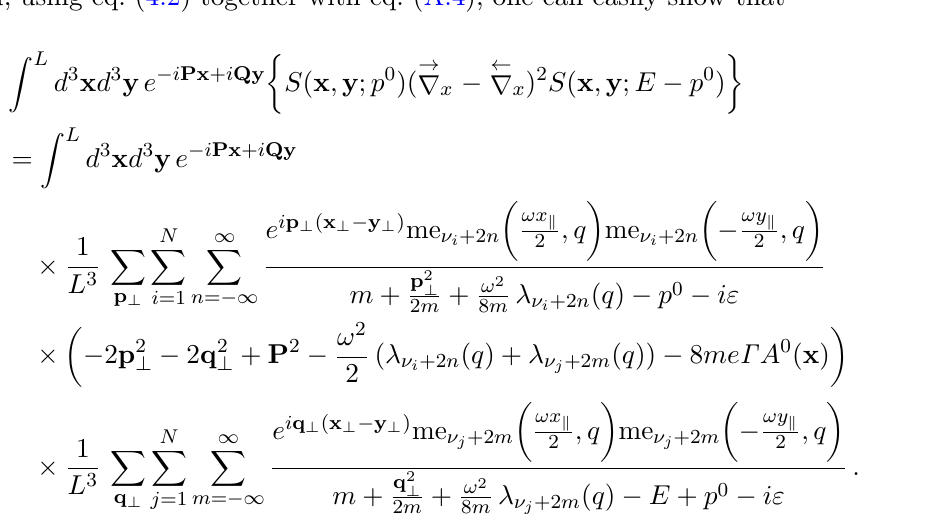
Figure 4 . Full one-particle propagator in the external